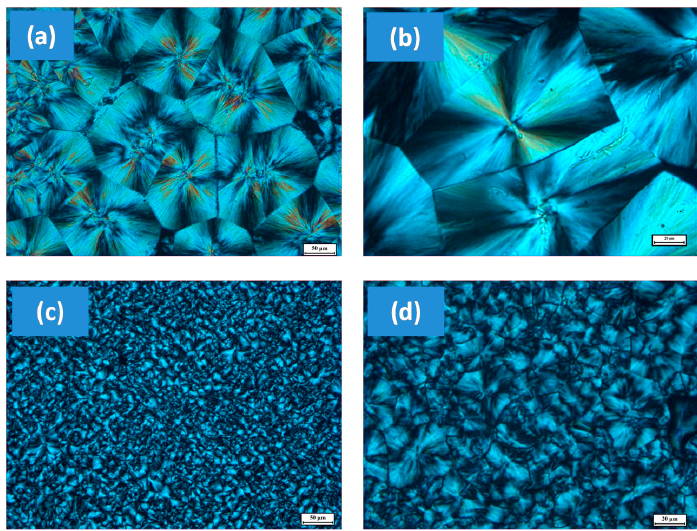
Figure 11. Polarization photomicrographs of the final morphologies of ( a , b ) neat PLA and ( c , d ) PLAC (PLA-graphene composite) after melt crystallization (120 °C); The scale bars are ( a , c ) 50 and ( b , d ) 20 μ m [65].